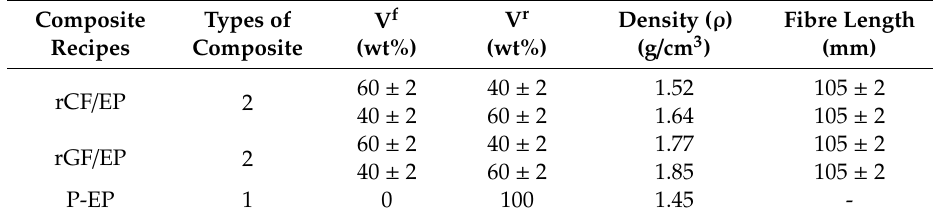
Table 1. Designed composites for compression